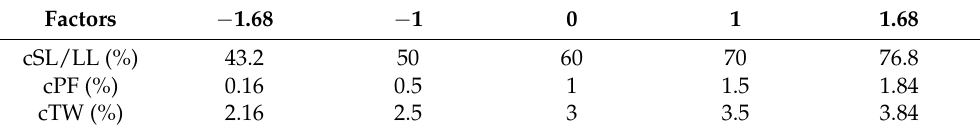
Table 3. Factors and their corresponding coded levels of experimental design.